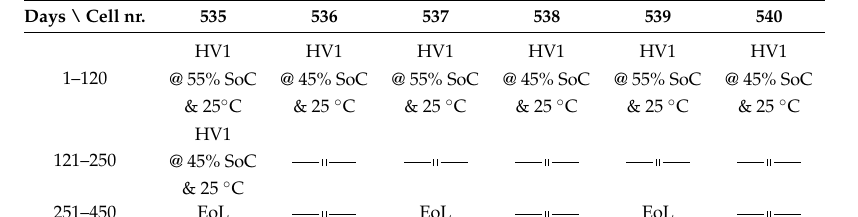
Table 1. Schedule of the conducted test sequences on cell-level repeating only one load profile.